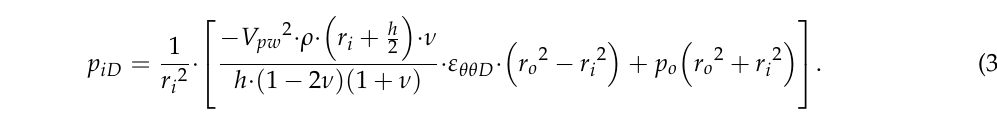
Table 1. This is a table caption. Tables should be placed in the main text near to the first time they are cited.